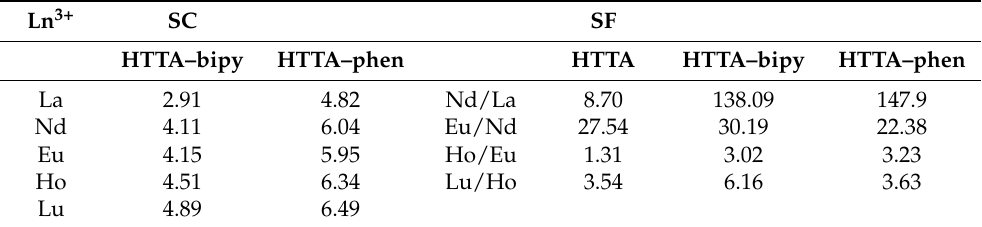
Table 8. Values of the synergistic coefficients ([HTTA] = 4 × 10 − 2 mol/dm 3 and [S] = 5 × 10 − 3 mol/dm 3 , phen: pH = 2.50; bipy: pH = 3.20) and separation factors for the lanthanoid extraction with HTTA alone and HTTA–S systems in CHCl 3 . Reprinted with permission from Ref.